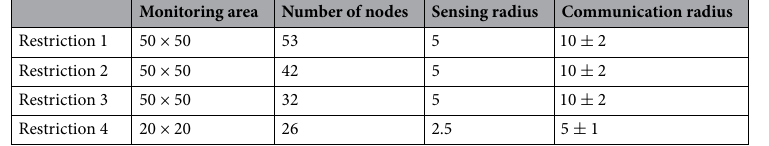
Table 2. Four types of restrictions.